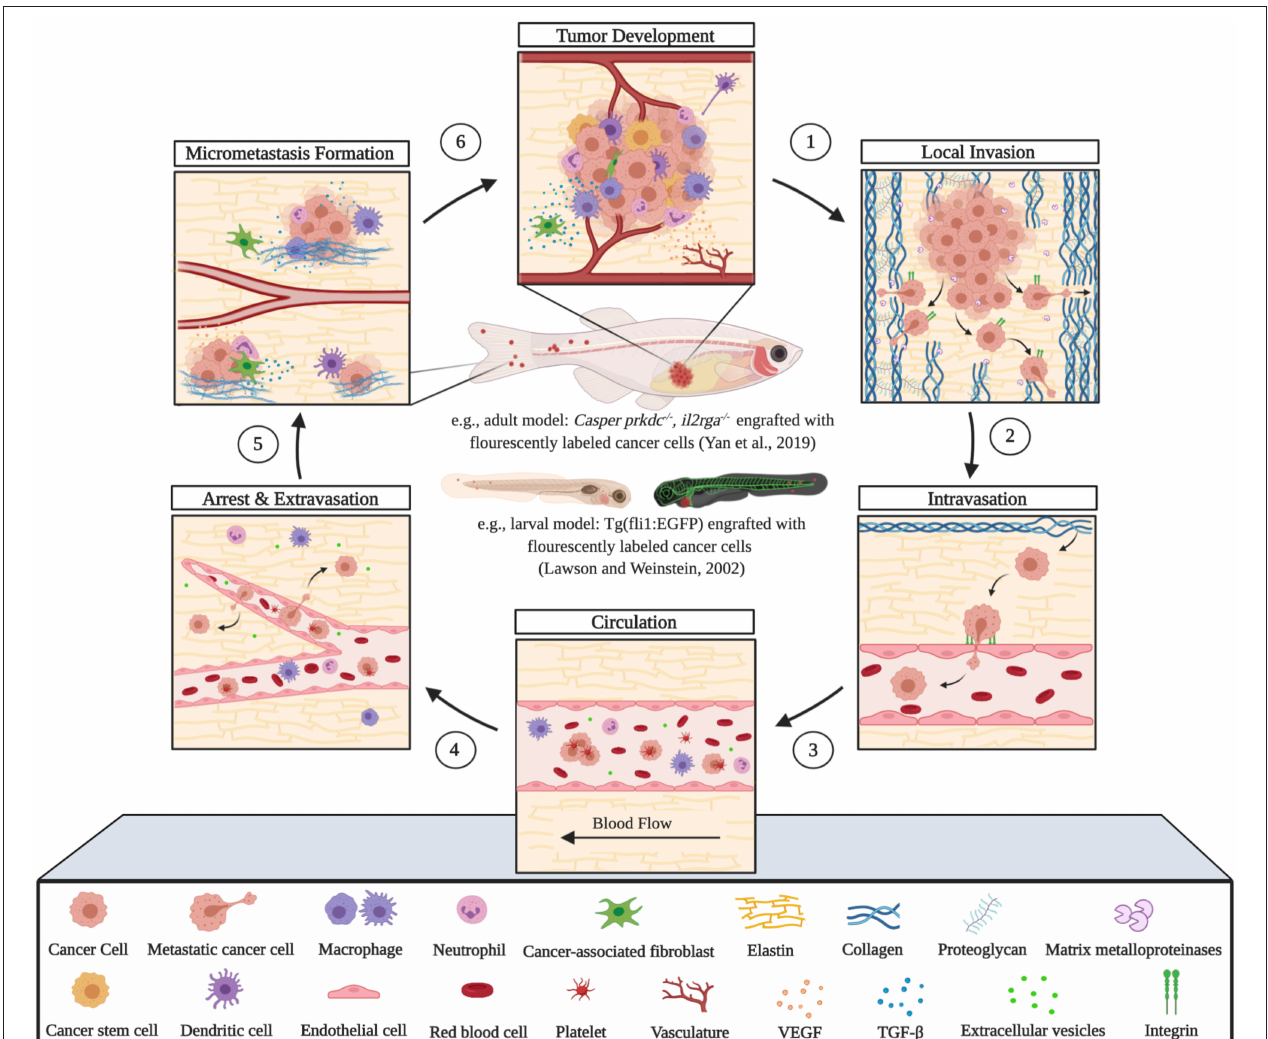
FIGURE 2 | Zebrafish tumor models represent an alternative for studying the metastatic cascade by faithfully mimicking the tumor microenvironment (TME). Larval and optically clear adult zebrafish models permit every step of a malignant cell’s journey to be visualized within the context of its TME.